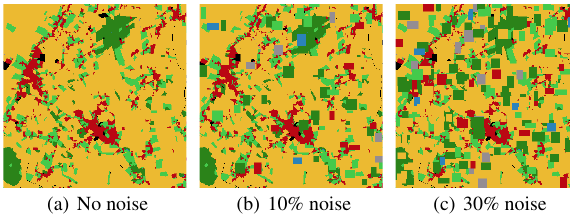
Figure 4. Examples for training data with different percentages of simulated label noise. Colour code: cf. figure